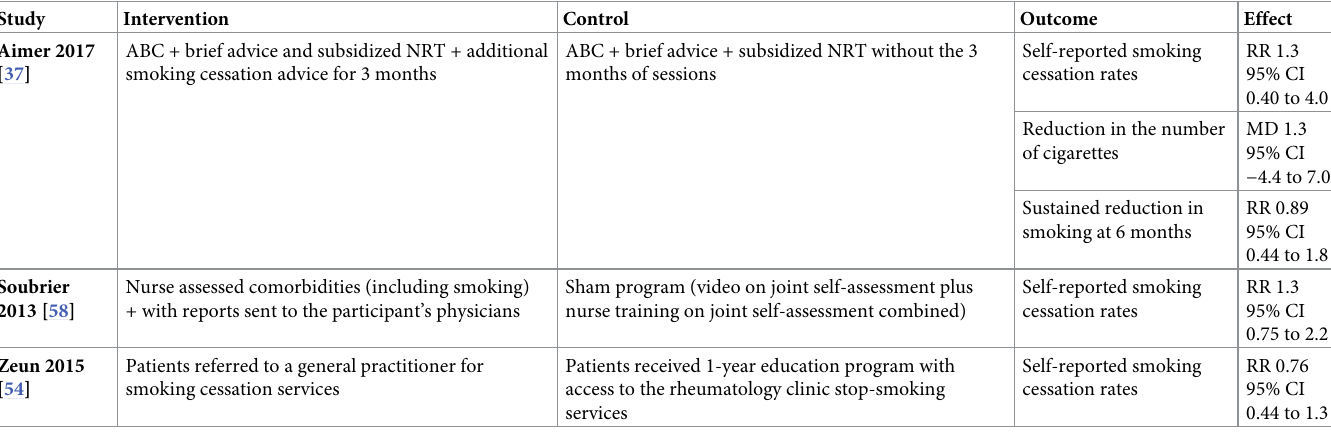
Table 3. Synthesis of results from controlled studies evaluating interventions targeting